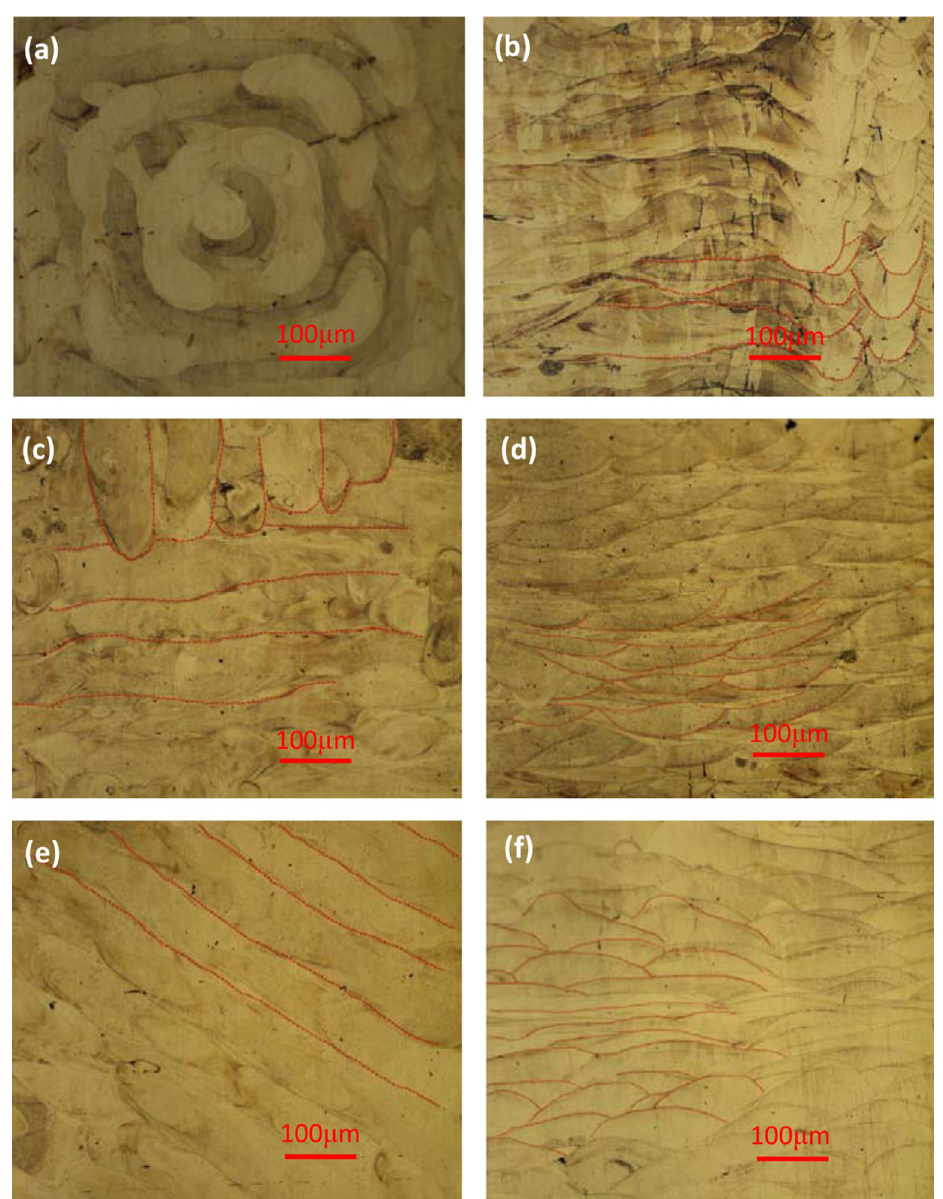
Figure 11. Weld pool of samples under different scanning strategies: ( a , b ) helix scanning; ( c , d ) Island scanning; ( e , f ) slope subarea scanning; ( a , c , e ) HD; ( b , d , f )